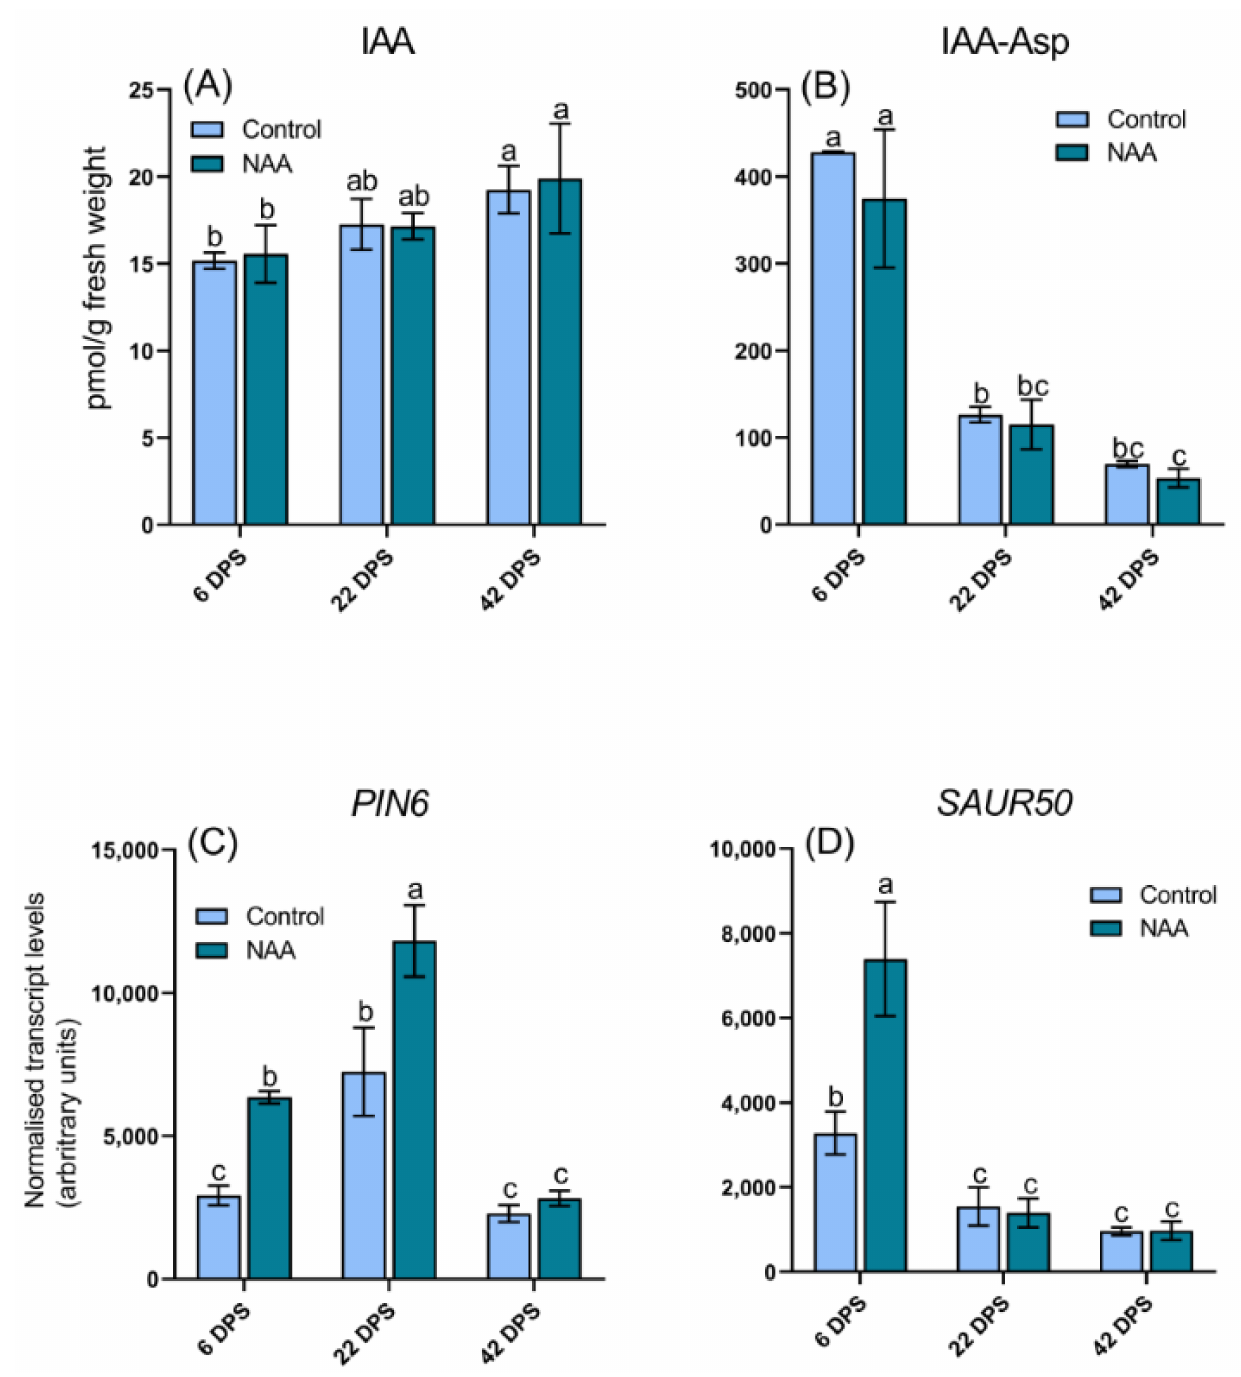
Figure 5. LC-MS/MS analysis of endogenous auxin concentrations in sweet cherry ( Prunus avium L.) fruit at three timepoints after the pre-ripening application of 100 mg/L NAA are shown including ( A ) indole-3-acetic acid (IAA) p = 0.0290 and ( B ) indole-3-acetic acid aspartate (IAA-Asp) p < 0.0001. qRT-PCR analysis is also shown for of auxin regulatory genes ( C ) PIN6 p < 0.0001 and ( D ) SAUR50 p < 0.0001. All data represent geometric means ± s. e. ( n = 3), bars are denoted by a different letter (a, b, c, ab, bc) if the means differ significantly using one-way ANOVA followed by Waller-Duncan’s post hoc test. DPS = days post